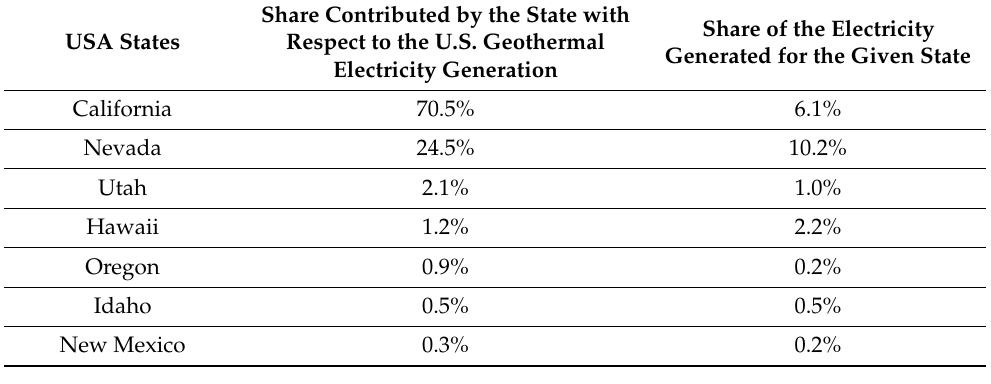
Table 2. Share of the electricity generated from geothermal energy by different states of the USA in 2020 [35].